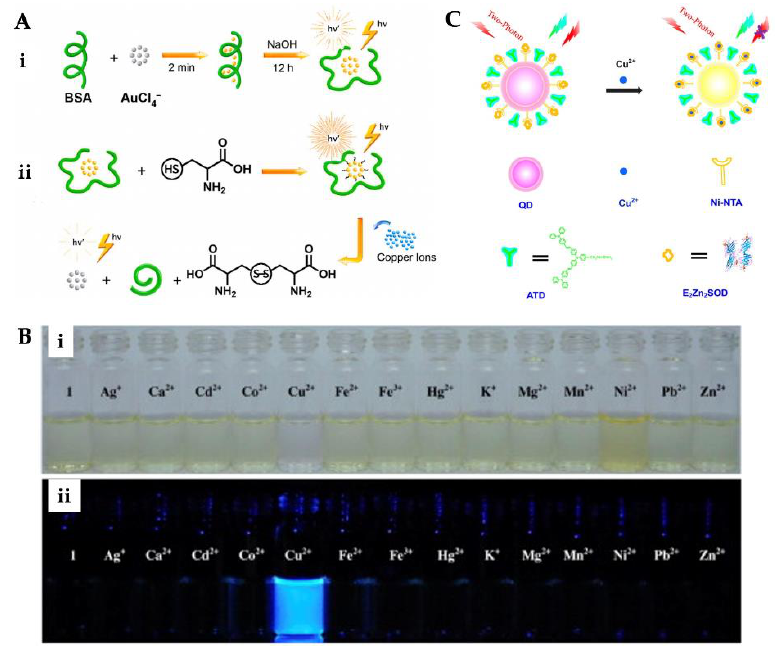
Figure 3. Preparation steps of fluorescence sensor for Cu 2+ ion detection ( A ), color ( i ) and fluorescence ( ii ) changes of sensor after addition of various metal ions ( B ). Scheme of the working principle of two-photon ratiometric imaging and sensing of Cu 2+ ion ( C ). Republished with permission from [98 – 100].